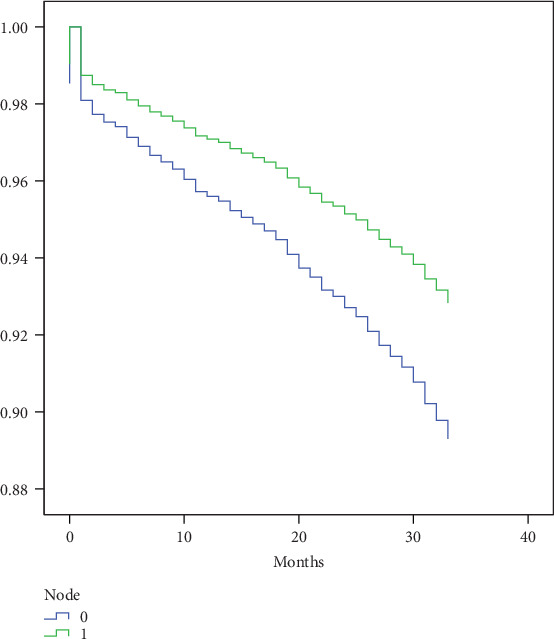
Validation K-M curves of SEER 2014 cohorts (green for ELN ≥21 nodes, blue for ELN <21 nodes).